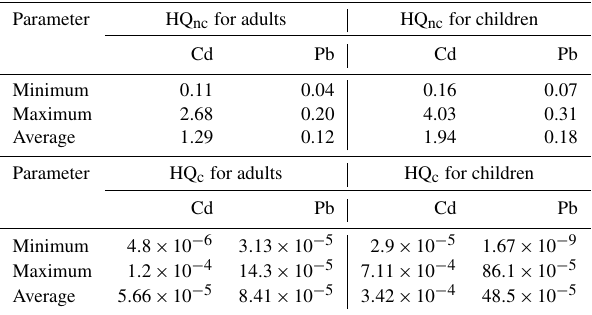
Table 5. Statistical parameters of non-carcinogenic and carcino- genic health risks for groundwater